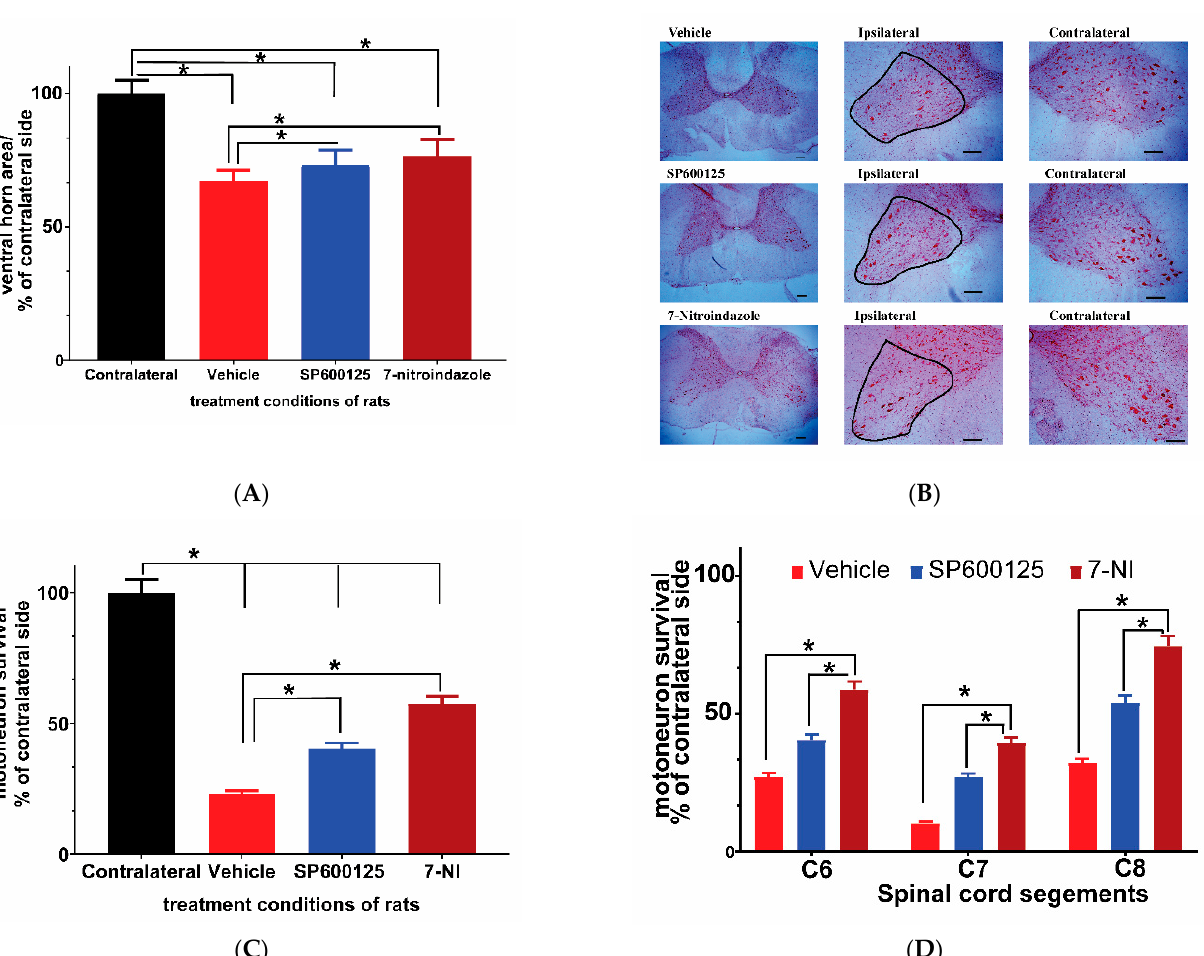
Figure 2. Ventral horn area and motor neuron survival in C6, 7, and 8 cervical segments 6 months after avulsion. ( A ) Comparison of ventral horn size (area) 6 months after avulsion between the control and SP600125 or 7-nitroindazole (7-NI) treatment groups ( n = 4/group). The sizes of the corresponding ipsilateral/contralateral areas were computed by planimetry. There was significant atrophy of ipsilateral ventral horns of vehicle, 7-nitroindazole, and SP600125-treated rats. Data expressed as mean ± SD, as a percentage of values determined in the corresponding contralateral side. Comparisons by one-way ANOVA followed by Tukey’s honestly significant difference (HSD) whereby * p < 0.05, n = 4 rats. ( B ) Neutral red-stained right ipsilateral and left contralateral ventral horns of the cervical spinal cord showing motor neurons (black outline) as seen under the light microscope (40× magnification) (scale bar, 100 μ m). The representative images of the left and right ventral horns of each of the groups: vehicle, SP600125, and 7-nitroindazole are shown. ( C ) Survival of motor neurons (expressed as the mean percentage of the contralateral side 6 months after avulsion) in control and the neuroprotective agent (7-nitroindazole and SP600125) treated rats. Data reported as mean ± SD, as a percentage of values determined in the corresponding contralateral side. * p < 0.05, n = 4 rats; Tukey’s HSD * p < 0.05). ( D ) Motor neuron survival in C6, 7, and 8 cervical segments 6 months after avulsion. The magnitude of motor neuron loss was greatest in the vehicle-treated rats compared to groups that received neuroprotective treatments. Generally, the 7th cervical segment had the least number of surviving motor neurons across all groups. Data expressed as mean ± SD, as a percentage of values determined in the corresponding contralateral side. * p < 0.05, n = 4 rats.